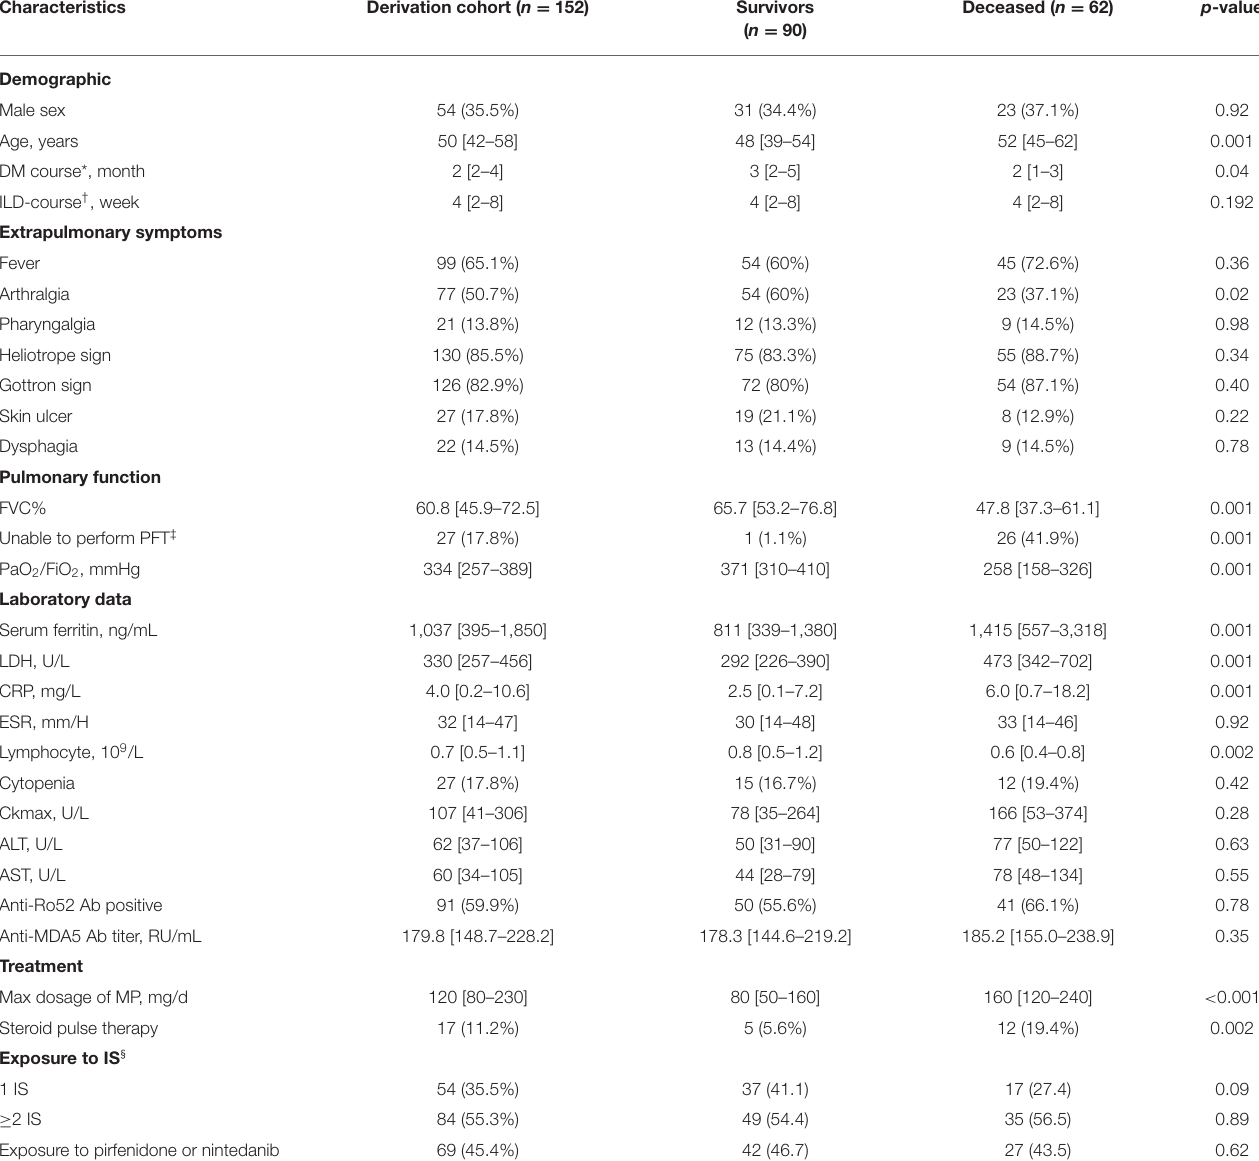
TABLE 2 | Univariable Cox regression results of baseline clinical characteristics and treatment between the survivors and deceased in the derivation cohort.